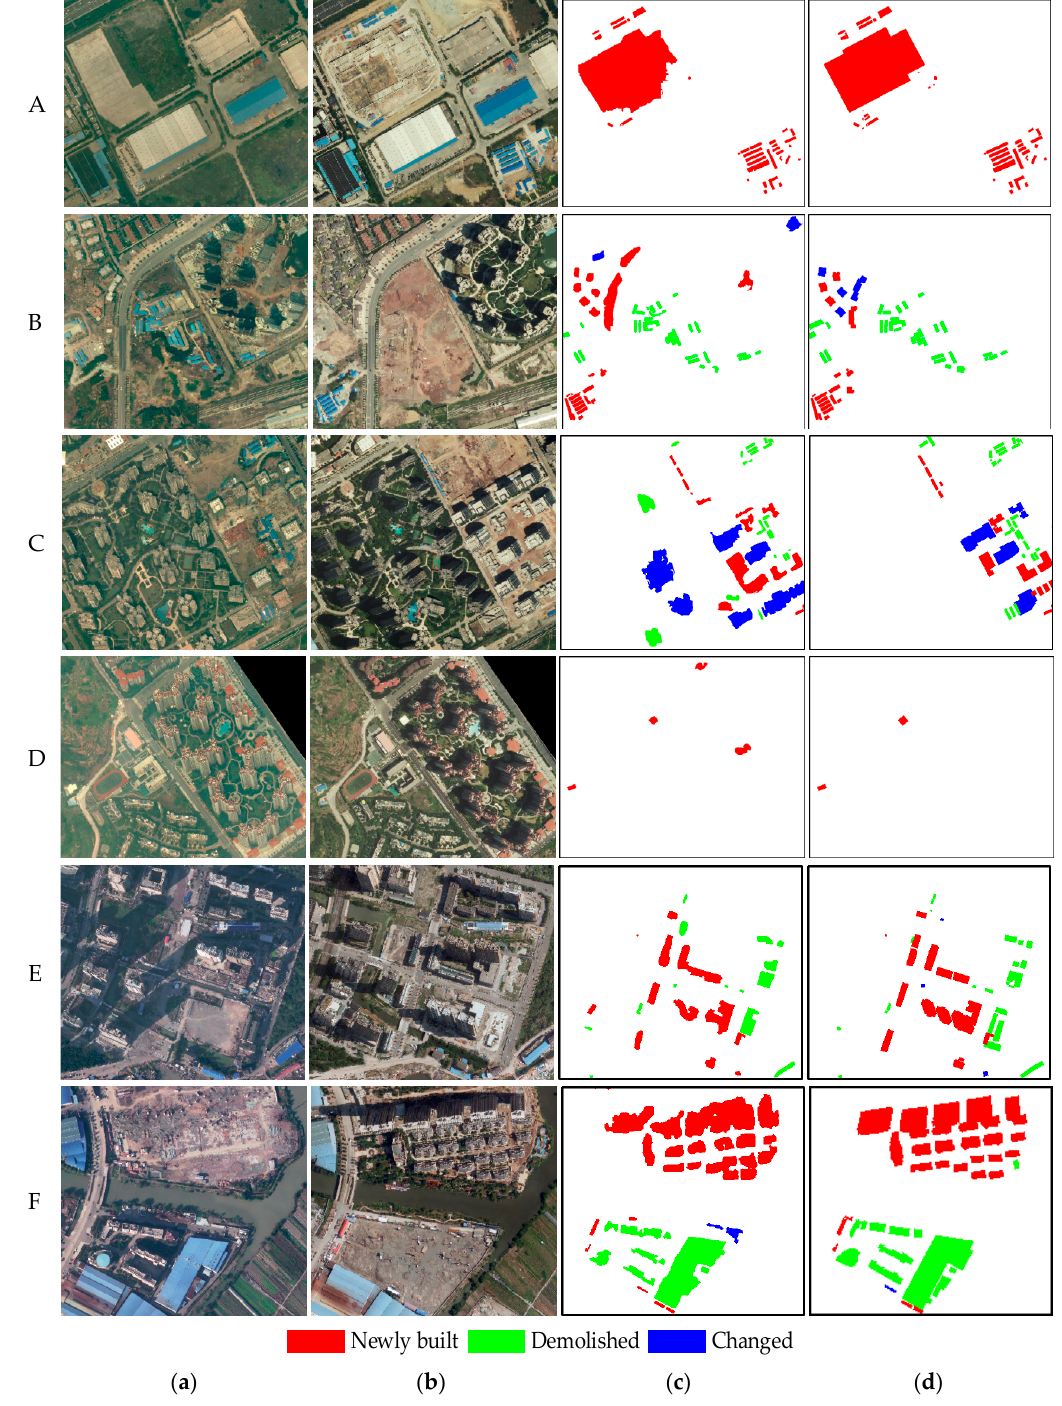
Figure 15. Amplified details of six typical regions: ( a ) Enlarged image subareas at time t 1 , ( b ) enlarged images at Time t 2 , ( c ) results of the proposed method, and ( d ) ground truth.